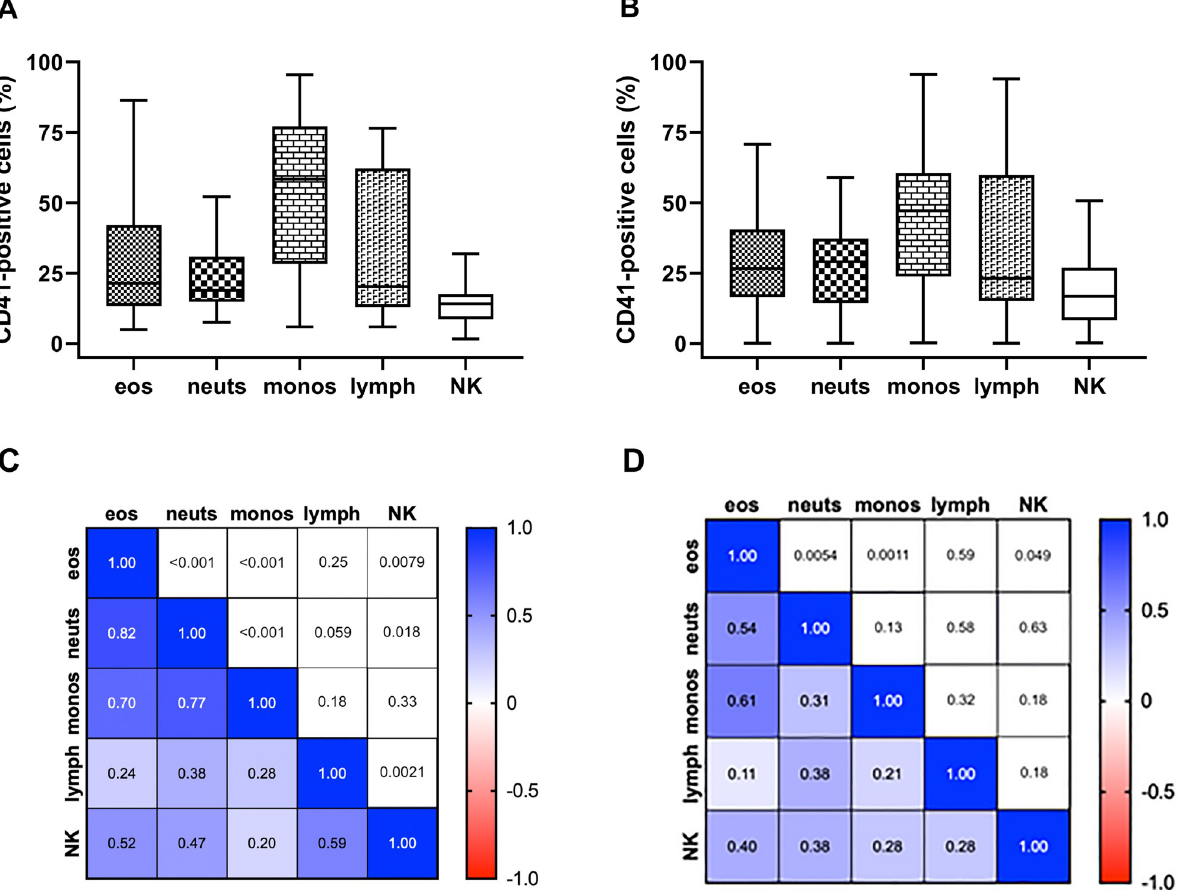
Fig 2. Blood leukocyte CD41 and correlations among leukocytes at V1 and V2. A and B) CD41-positive leukocytes at V1 (A) and V2 (B), median and quartiles. C and D) Correlations among the various leukocytes at V1 (C) and V2 (D). Numbers in colored lower left area represent Spearman rank (in C) and Pearson (in D) correlation coefficient values, respectively. Numbers in white upper right area represent p values. Eos, eosinophils; lymph, lymphocytes; monos, monocytes; neuts, neutrophils; NK, natural killer cells.